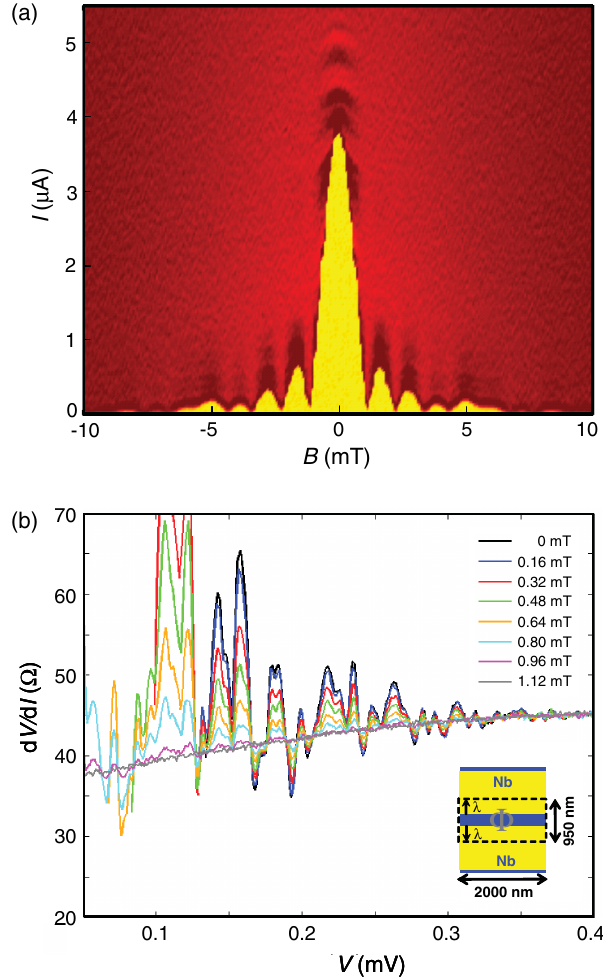
FIG. 4. (a) Colorplot of dV=dI dataversuscurrent bias (ascend- ing sweeps) and an applied magnetic field ( T ¼ 25 mK ). The dV=dI dataarenumerically derivedfrommeasured I - V character- istics at different magnetic-field values. The yellow color corre- sponds to the supercurrent regime ( dV=dI ¼ 0 ) and the red color to the normal-state regime ( dV=dI > 0 ). A Fraunhofer pattern =A ), providing appears with a periodicity of (cid:2) B (cid:2) 1 : 1 mT ( (cid:2) (cid:3) 0 evidence that the supercurrent is carried predominantly by 2 (cid:1) -periodic Andreev bound states. The deviation from a perfect Fraunhofer pattern indicates a nonuniform supercurrent through the junction. (b) Measured dV=dI versus the voltage across the junction (ascending bias sweeps) at different magnetic-field val- ues ( T ¼ 25 mK ). The amplitude of the reproducible, aperiodic fluctuations is maximal at B ¼ 0 , decreases with the magnetic field, and vanishes completely at B (cid:2) 1 : 1 mT (when one flux quantum is captured in the effective junction area). This implies that the fluctuations originate from the Josephson effect. The effective junction length of 950 nm incorporates the magnetic penetration length of the Nb (see